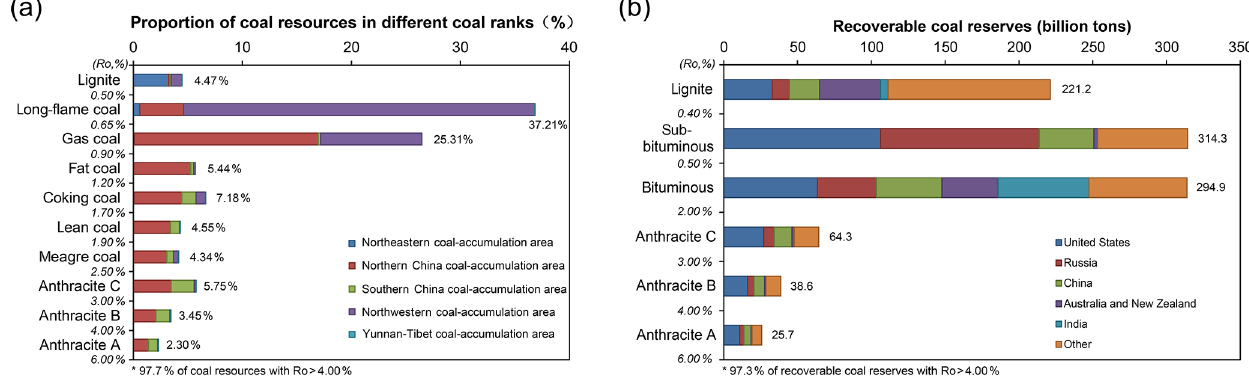
Figure 6. The variation in proven coal reserves with coal ranks in China and in the world. (a) The proportion of proven coal reserves with different coal ranks in China (data from CCRR, 1996; CNACG, 2016). The coal ranks are classified according to the Chinese standard, and the coal-accumulation area is shown in Fig. 1. (b) The recoverable coal reserves with different coal ranks around the word (data from Conti et al., 2016). The coal ranks are classified according to international standards. The proven coal reserves of anthracite C, B, and A are projected according to their variation